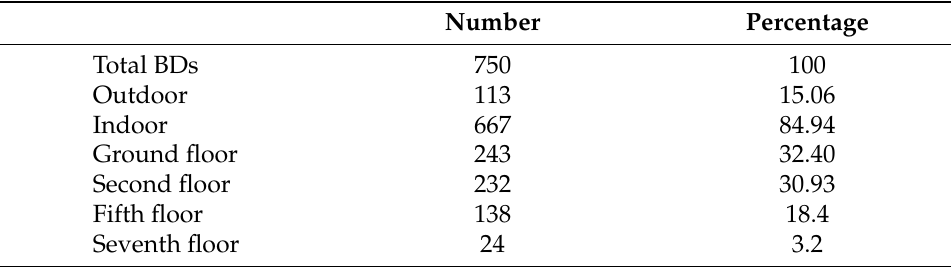
Figure 5. Distribution of backscatter devices. Table 1. Distribution of backscatter